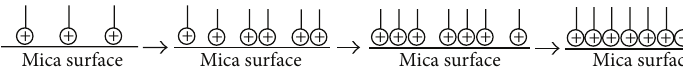
Figure 8: FW-134 adsorption schematic diagram on mica